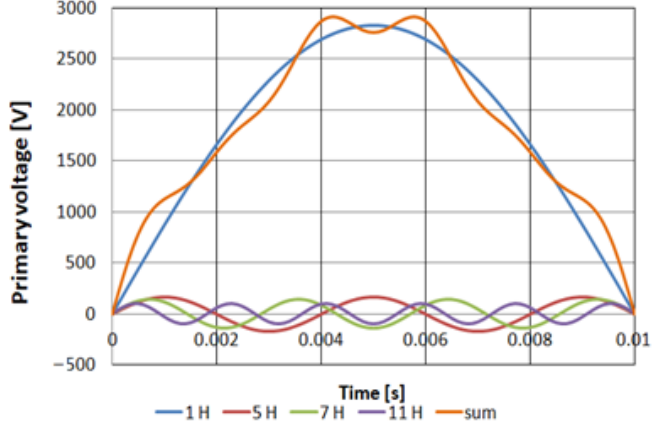
Figure 6. The shape of the voltage in the power network allowed by the European Standard EN 50160 (where 1H—means the first harmonic 50 Hz and, respectively, 3H—the third harmonic with amplitude permitted by the standard, etc.).